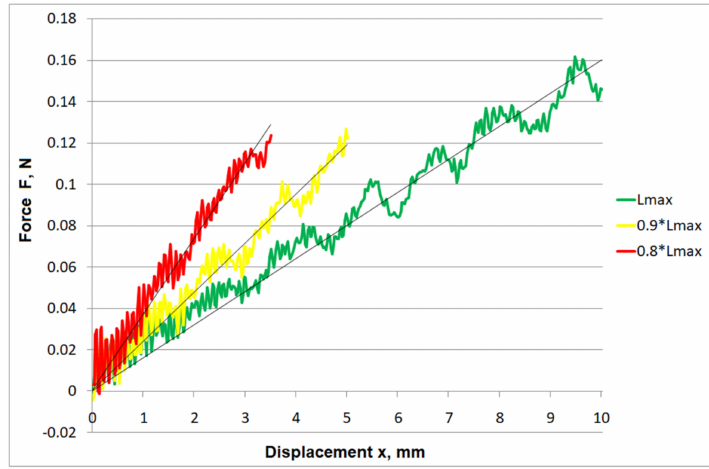
Figure 8. Aggregated F(x) chart for single cutting elements.